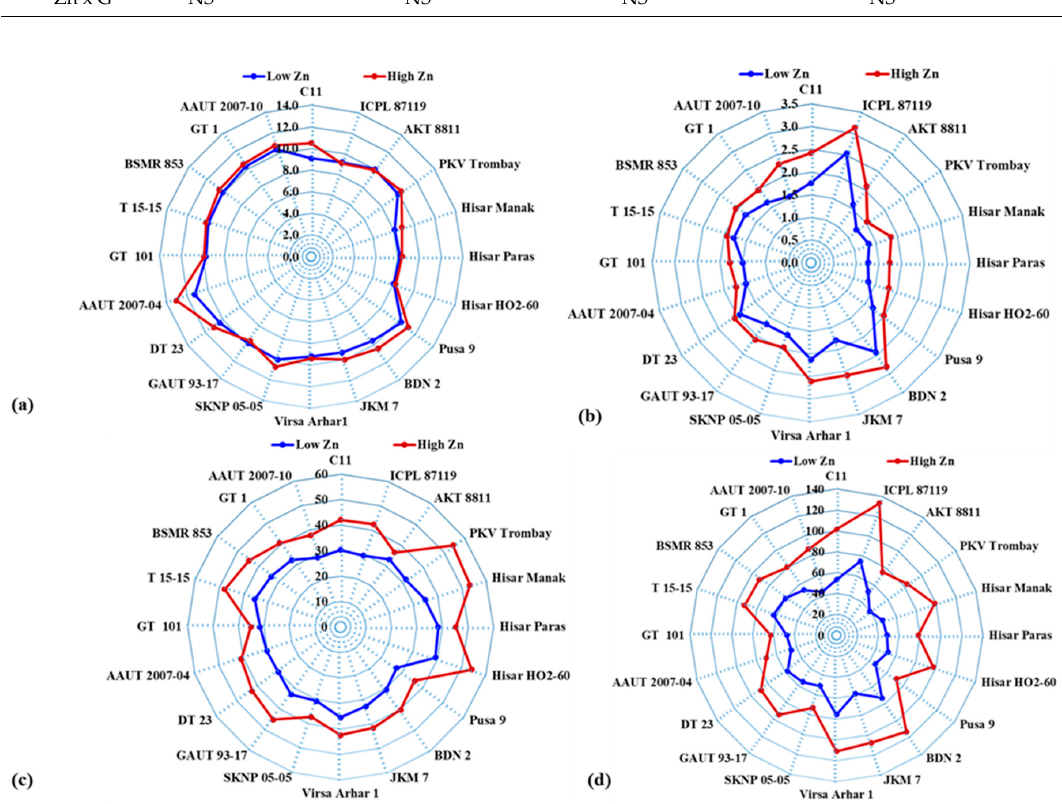
Figure 2. Radar diagrams showing mean ( a ) 100 seed weight (g), ( b ) seed yield (t ha − 1 ), ( c ) seed zinc (Zn) concentration (mg kg − 1 ), and ( d ) seed Zn uptake (g ha − 1 ) of pigeonpea genotypes grown under low and high Zn treatments.